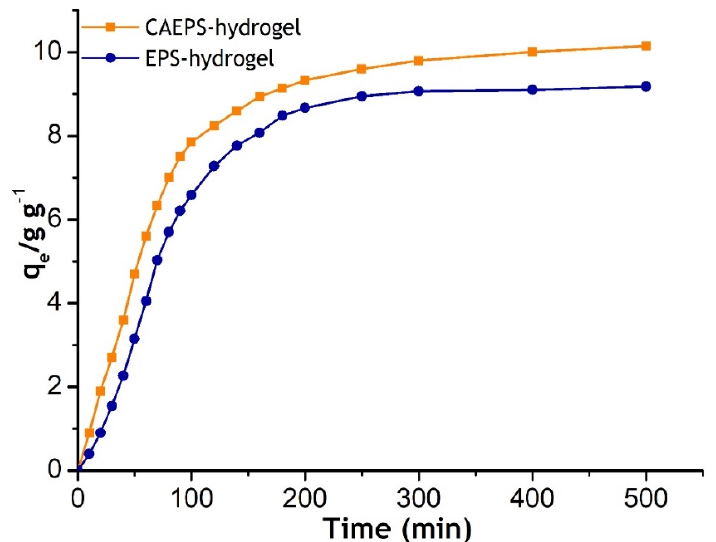
Figure 8. Swelling kinetic curve of EPS-hydrogel and CAEPS-hydrogel. Note: The freeze-dried gels were placed in distilled water for static absorption.